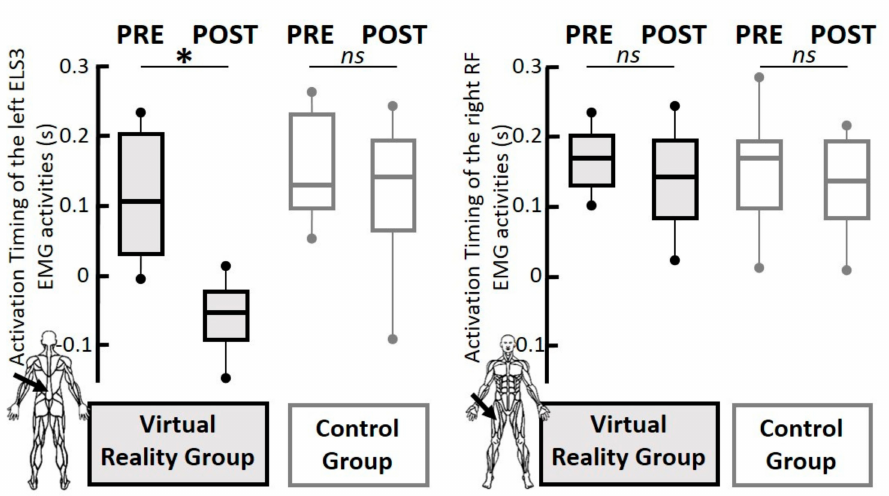
Figure 6. Boxplot graphs. In each reported parameter, the box and whiskers report the values of all the recordings for all participants. The box is defined by the first and third quartiles. The thick line within the box represents the median value. The tenth and ninetieth percentiles are plotted as circles above and below the whisker bars. All participants in the VR group are reported in black lines with a grey area, and the CTRL group in grey lines with a white area. Left panel: Boxplot graphs of the activation timing (second) of the left erector spinae at the third lumbar vertebra (lESL3) EMG activities. Right panel: Boxplot graphs of the right rectus femoris (rRF) EMG activities. The location of the concerned muscle is reported by a black arrow on a body schema in each graph. ns , p > 0.05; *, p <